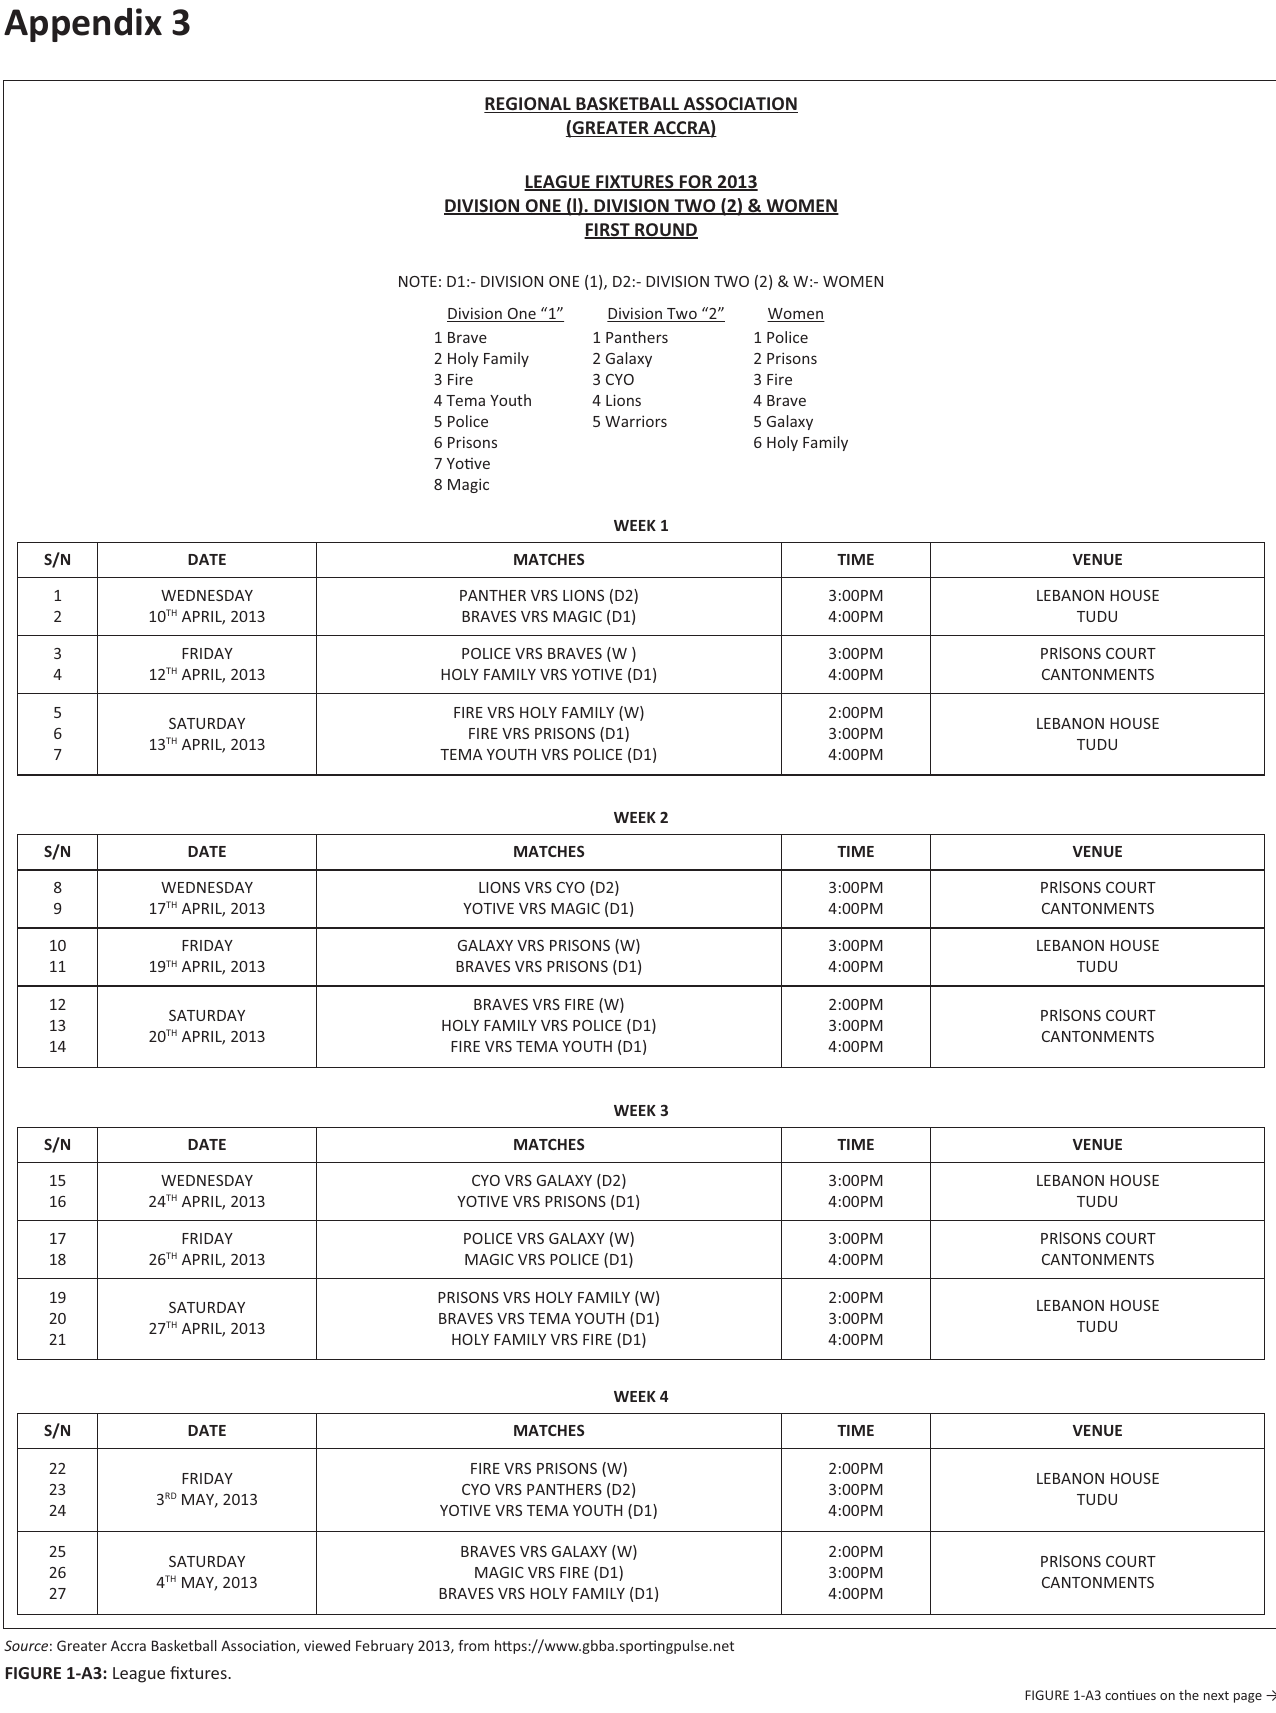
FIGURE 1-A3 contiues on the next page →